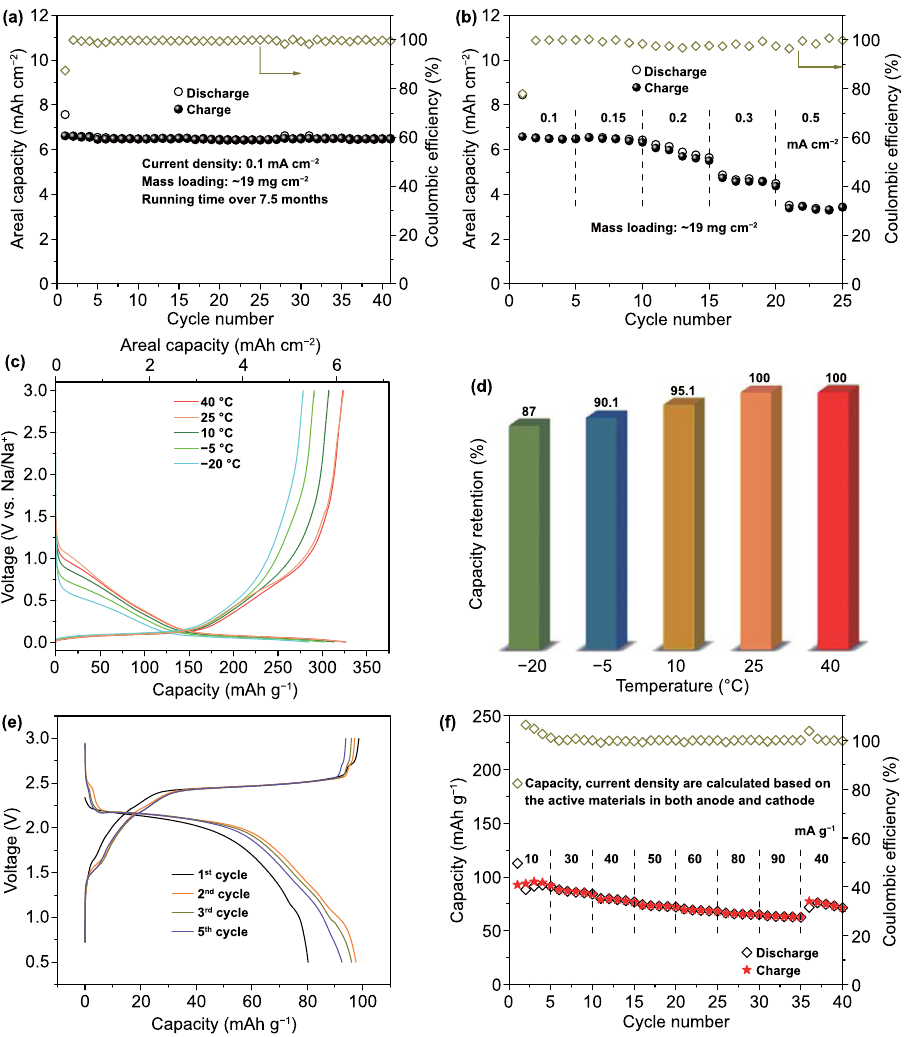
Fig. 5 Thick electrode and full‑cell test. a Cycling performance, and b rate capability of the thick electrode with a mass loading of ~ 19 mg cm −2 . c galvanostatic discharge/charge curves at 0.2 mA cm −2 in the temperature range from − 20 to 40 °C and d the capacity retentions of thick electrode. e Galvanostatic discharge/charge curves at 10 mA g −1 and f rate capability of full cell in the voltage range of 0.5–3.0